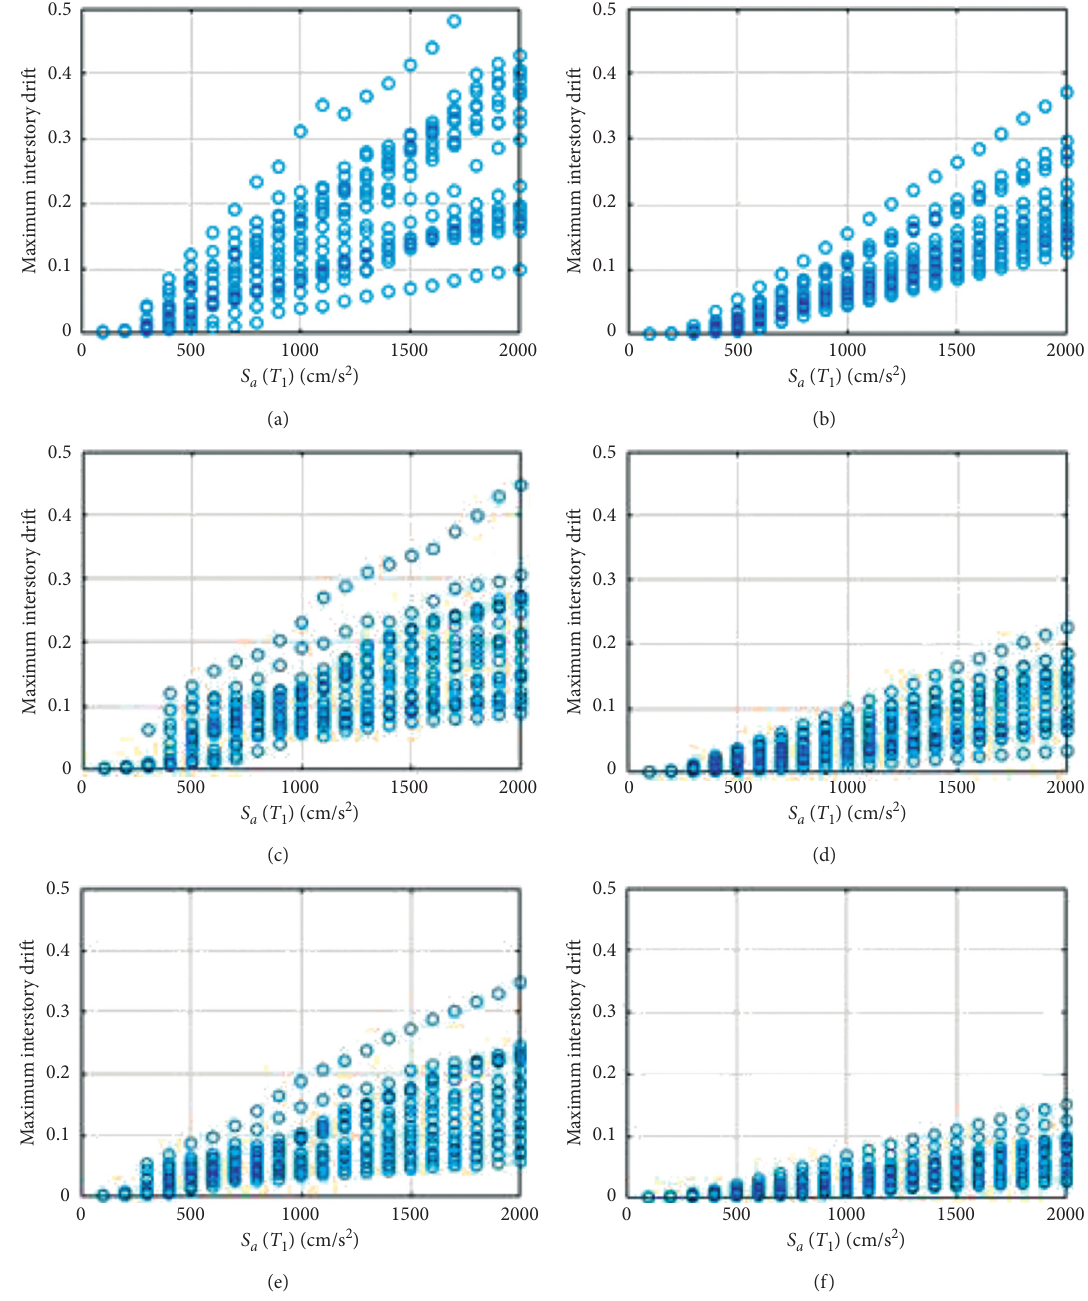
Figure 4: Incremental dynamic analysis curves for the buildings: (a) RC3, (b) RC3-BRB, (c) RC6, (d) RC6-BRB, (e) RC9, and (f)